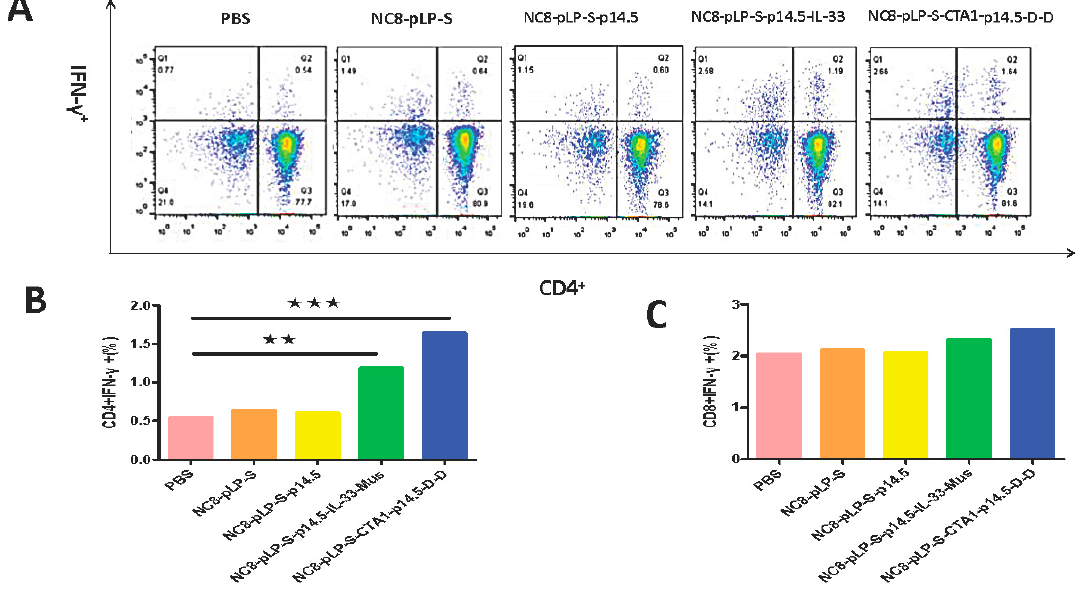
Figure 3. Flow cytometry to detect IFN- γ secretion. ( A ) Changes in CD4 + IFN- γ + in the spleen; ( B ) Statistical histogram of CD4 + IFN- γ + changes in spleen; ( C ) Statistical histogram of CD8 + IFN- γ + changes in spleen. The degree of B cell differentiation in descending order is the CTA1-DD adjuvant group, IL-33 adjuvant group, single antigen group, empty vector group and the control group. ** p < 0.01 and *** p < 0.001 compared with PBS group.